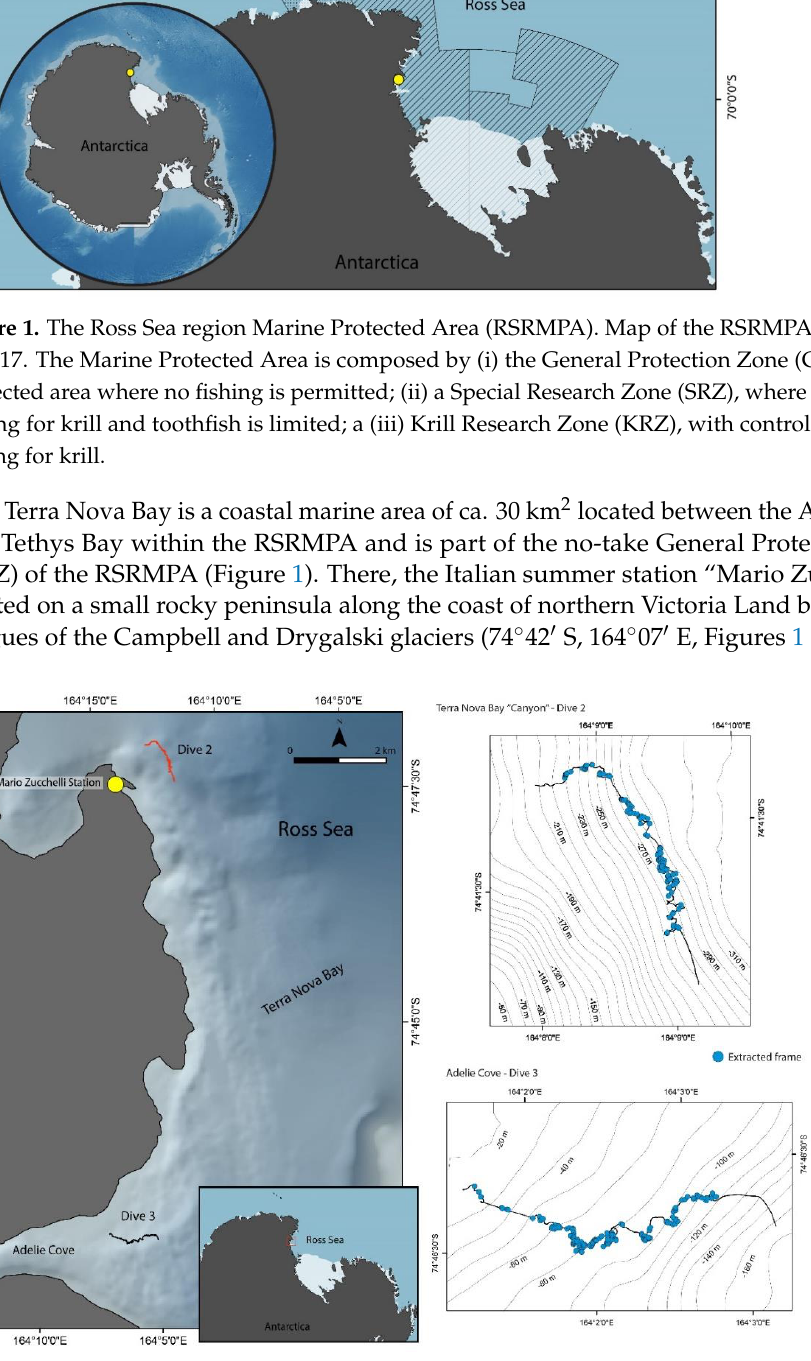
Figure 2. Location of visual benthic surveys. Map showing the location of ROV benthic surveys and of the extracted frames used for taxonomical identification at Terra Nova Bay “Canyon” and Adélie Cove.